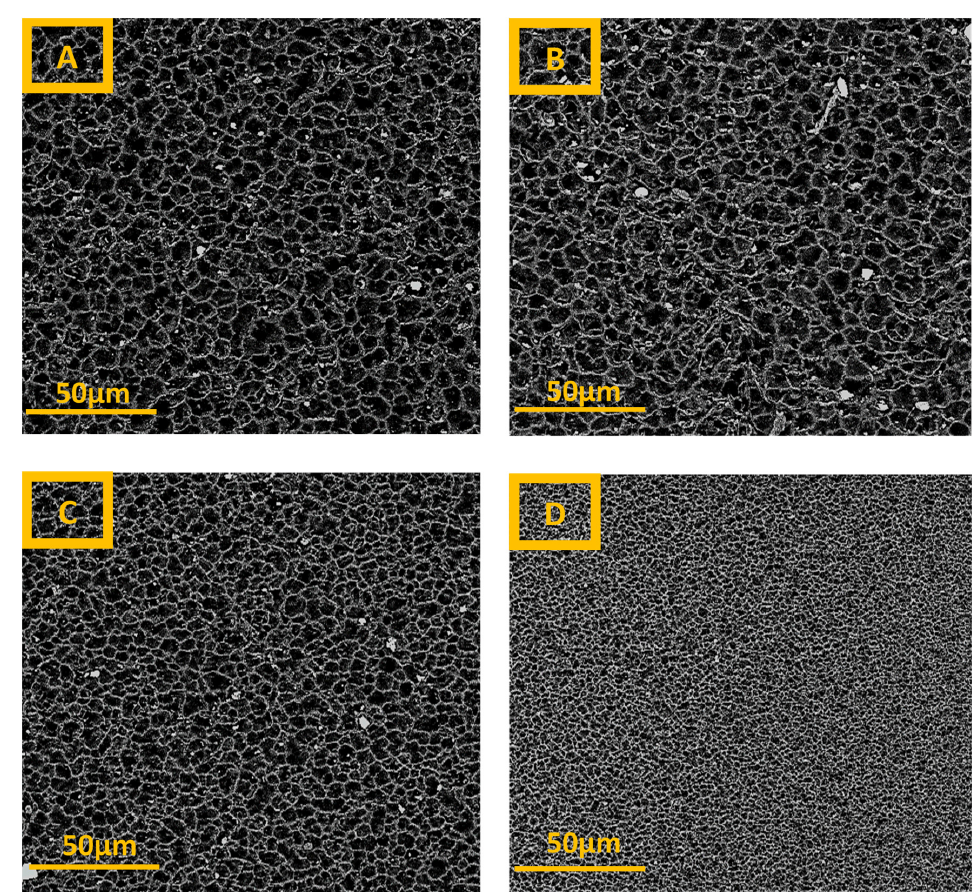
Figure 5. The SEM images with magnification of 1500 × for PA6 membranes with various gelation